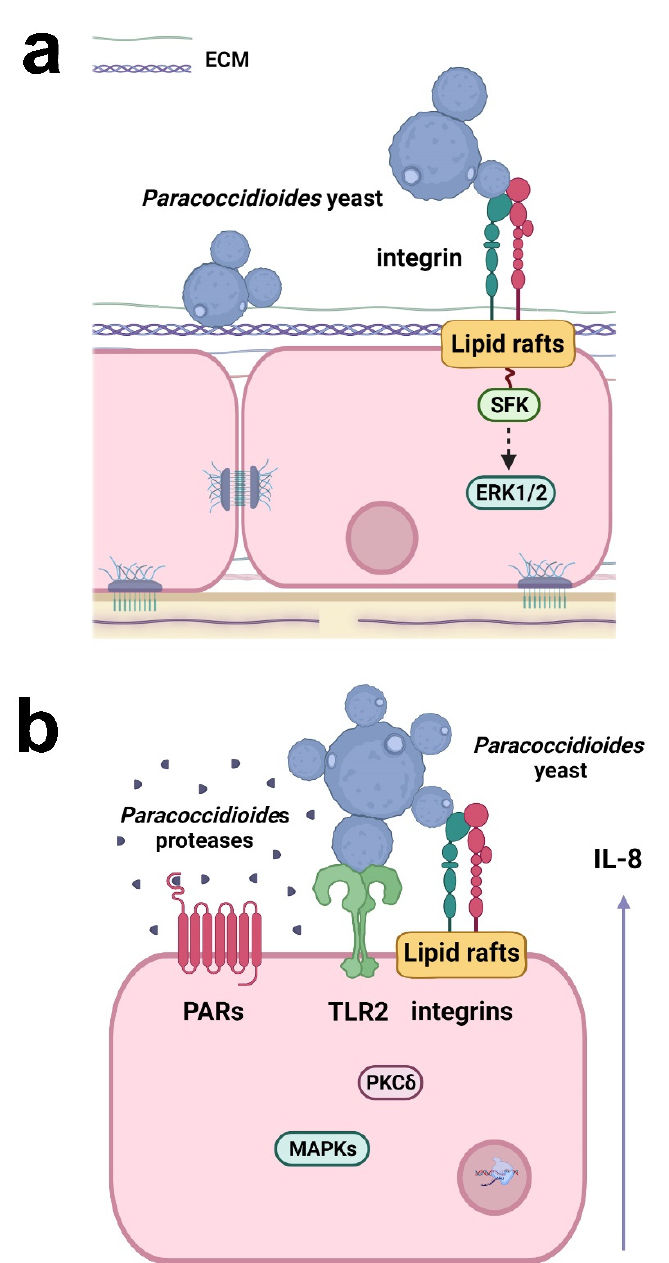
Figure 2. Responses of respiratory epithelial cells to Paracoccidioides infection. ( a ) Paracoccidioides yeasts can bind to host ECM proteins and α 3 and α 5 integrins. Fungal adhesion is also dependent on lipid raft clustering, which promotes Src-family kinase (SFK) and ERK1/2 activation. ( b ) Paracoccidioides induces IL-8 cytokine secretion in epithelial cells by interacting with α 3 and α 5 integrins and TLR2. Fungal proteases may also activate PAR-1 and PAR-2 in epithelial cells, leading to IL-8 production. The secretion of IL-8 is promoted by Paracoccidioides and is dependent on lipid raft clustering and the activation of MAPK (p38MAPK, ERK1/2) and PKC δ . Created with Biorender.com. P. brasiliensis (Pb18 isolate) can manipulate epithelial cell signaling pathways to secrete the proinflammatory cytokines IL-6 and IL-8, but not the anti-inflammatory cytokine IL- 10 [94–96]. The interaction of P. brasiliensis with epithelial cells promotes the activation of protein kinase C (PKC) δ and the MAPKs p38 and extracellular signal-regulated kinase (ERK) 1/2, which are important for the secretion of IL-6 and IL-8 (Figure 2) [94,95]. TLR2, α 3 and α 5 integrins, and lipid rafts also participate in IL-8 secretion (Figure 2)